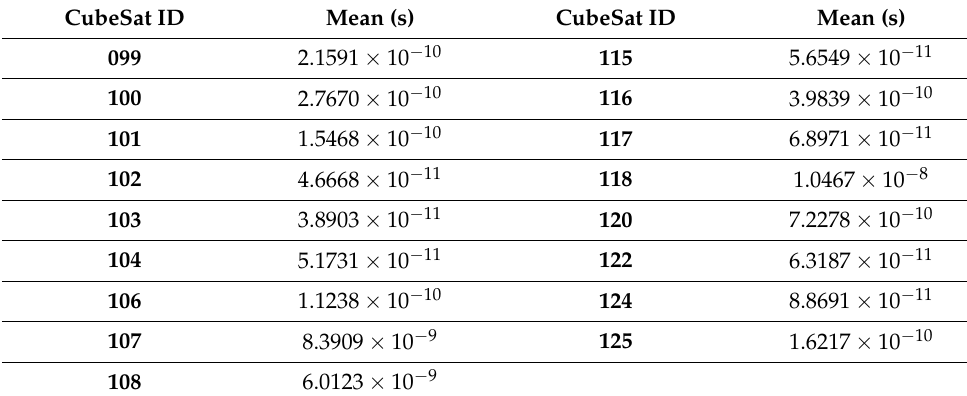
Table 6. Mean values of the clock differences between with/without applying J 2 corrections in the